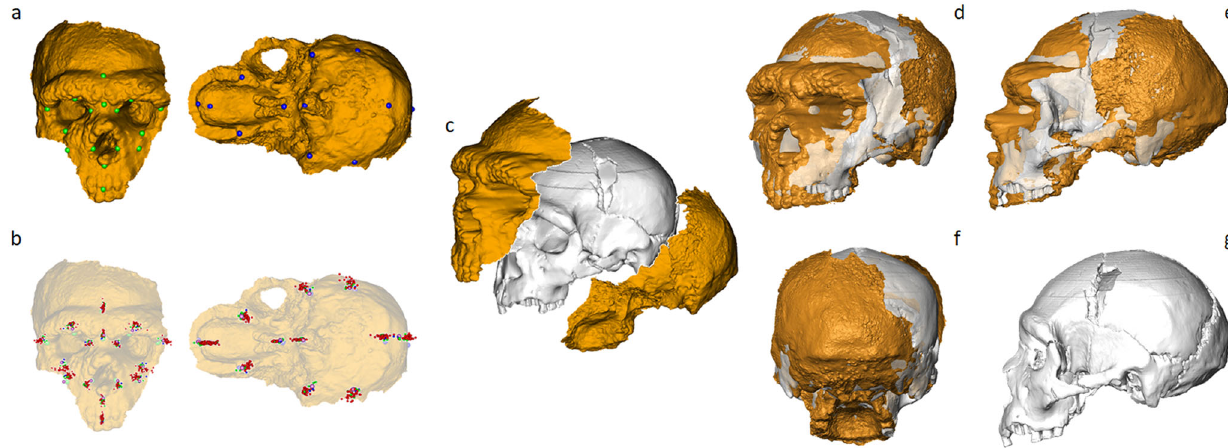
Fig. 2 Virtual reconstruction of the Altamura cranium. a Homologous landmark con fi gurations were acquired on the FF and BP of Altamura and of a reference specimen, the nearly complete Cranium 5 from the Sima de los Huesos site (SH-5); b landmark coordinates were processed separately by Generalised Procrustes Analysis (GPA); c FF and BP were aligned according to the reference specimen showing the highest morphological af fi nity; d – f various views of the virtual model of Altamura aligned on SH-5; g SH-5 lateral